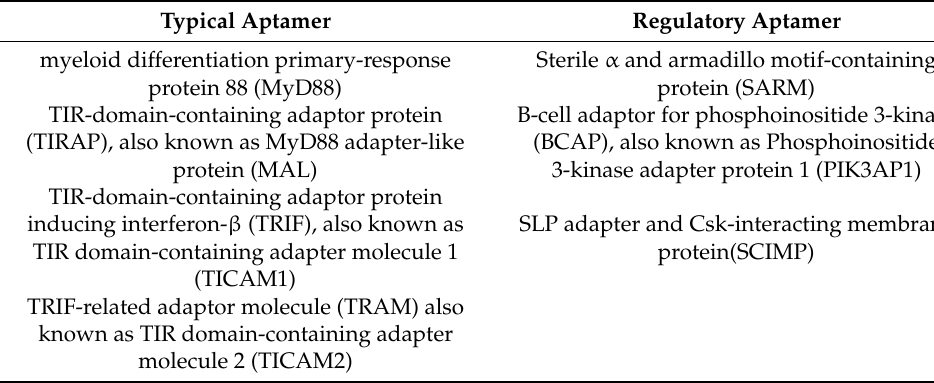
Figure 3. Inflammation and TLRs. Innate immunity and inflammation are two major defense mechanisms in the body. Activation of TLRs releases inflammatory factors, and TLRs are an important mediators between the inflammatory response and innate immunity. Table 1. Classification of TLR-related adapters.